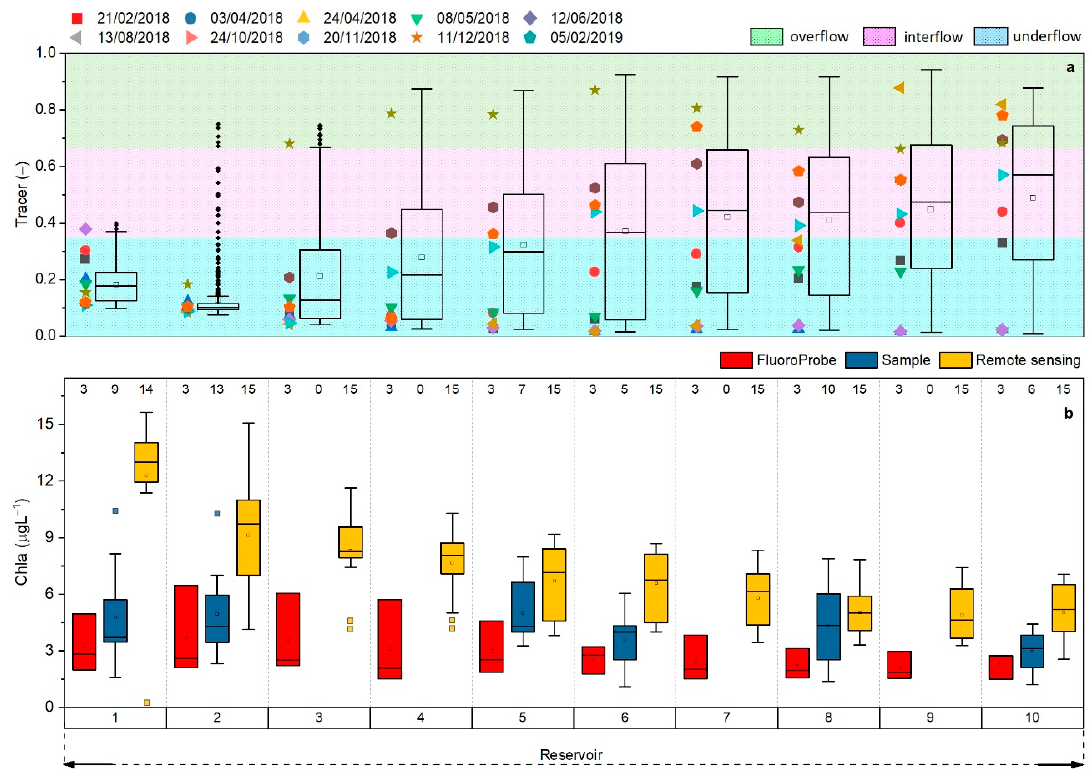
Figure 7. ( a ) Box plots of the temporal variations of the tracer ratio ( Tr , Equation (1)) averaged for each section. The background color marks the thresholds for the three classifications of density currents (see legend). Each campaign is marked as a scatter plot. ( b ) Box plots showing the variability of different estimates of chla in the 10 longitudinal zones (vertical grey lines indicate each section as divided in panel ( a ). Yellow box plots represent the temporal variation of chla from remote sensing. Blue box plots represent the temporal variation of chla measured by analyses of water samples, for which sampling points were grouped according to sections. Red box plots represent the temporal variation of chla measured during the three continuous longitudinal transects with the FluoroProbe sensor (Figure 5).